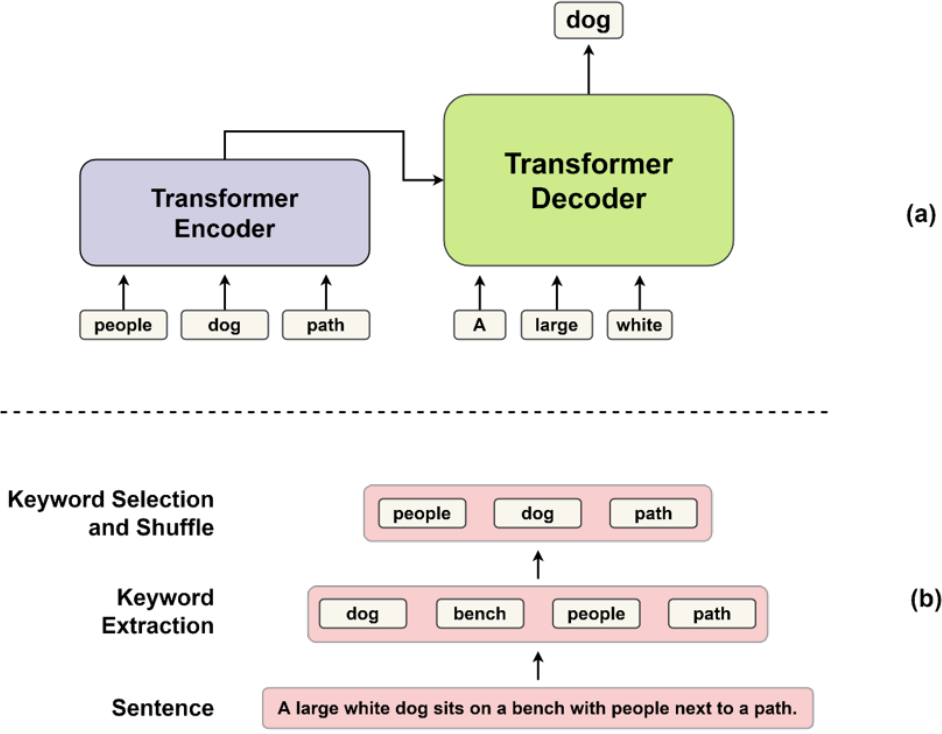
Figure 6. Input generation and training method in pre-training phase. ( a ) When keyword data is fed into a pre-training model encoder, the decoder learns to generate the original sentences. ( b ) Shows how to create input data from a sentence. After extracting keywords, we select some and then